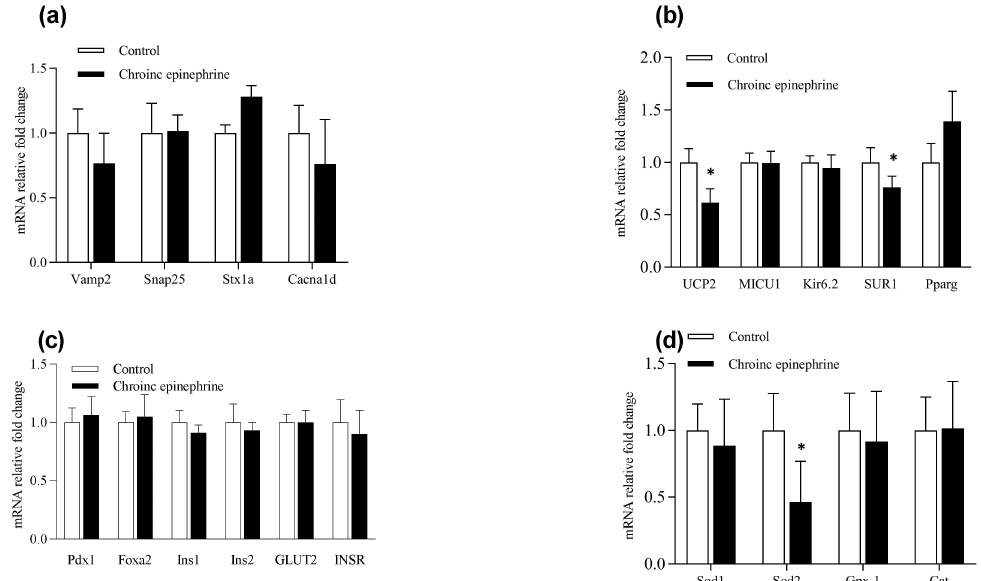
Figure 7. Expression levels of related insulin secretion signals in isolated pancreatic islets. The relative fold changes of ( a ) endocytosis and exocytosis and ( b ) signals associated with mitochondria and ATP synthesis, ( c ) insulinogenesis and ( d ) oxidative damage are determined in control ( n = 6) and Epi rats ( n = 7). *, p < 0.05. Vamp2 , vesicle-associated membrane protein 2; Snap25 , synaptosome associated protein 25; Stx1a , syntaxin 1A; Cacna1d , calcium voltage-gated channel subunit alpha1 D; UCP2 , uncoupling protein 2; MICU1 , mitochondrial calcium uptake 1; Kir6.2 , ATP-sensitive K + channel subunit; SUR1 , sulphonylurea receptor 1; Pparg , peroxisome proliferator-activated receptor gamma; Pdx1 , pancreatic and duodenal homeobox 1; Foxa2 , forkhead box A2; Ins1 , insulin1; Ins2 , insulin2; GLUT2 , glucose transporter type 2; INSR , insulin receptor; Sod1 , superoxide dismutase 1; Sod2 , superoxide dismutase 2; Gpx-1 , glutathione peroxidase 1; Cat ,